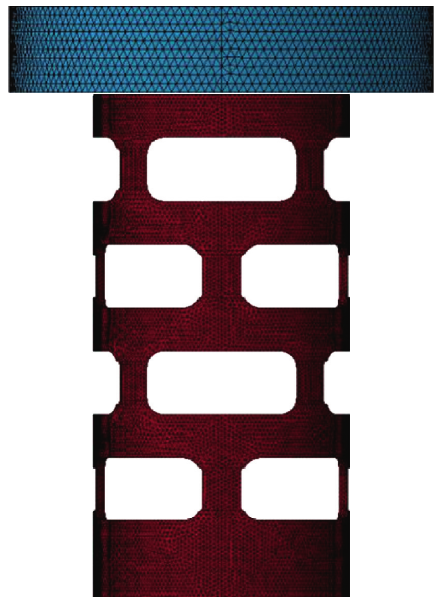
Figure 3: Finite element model of crushing buckling simulation for crushing